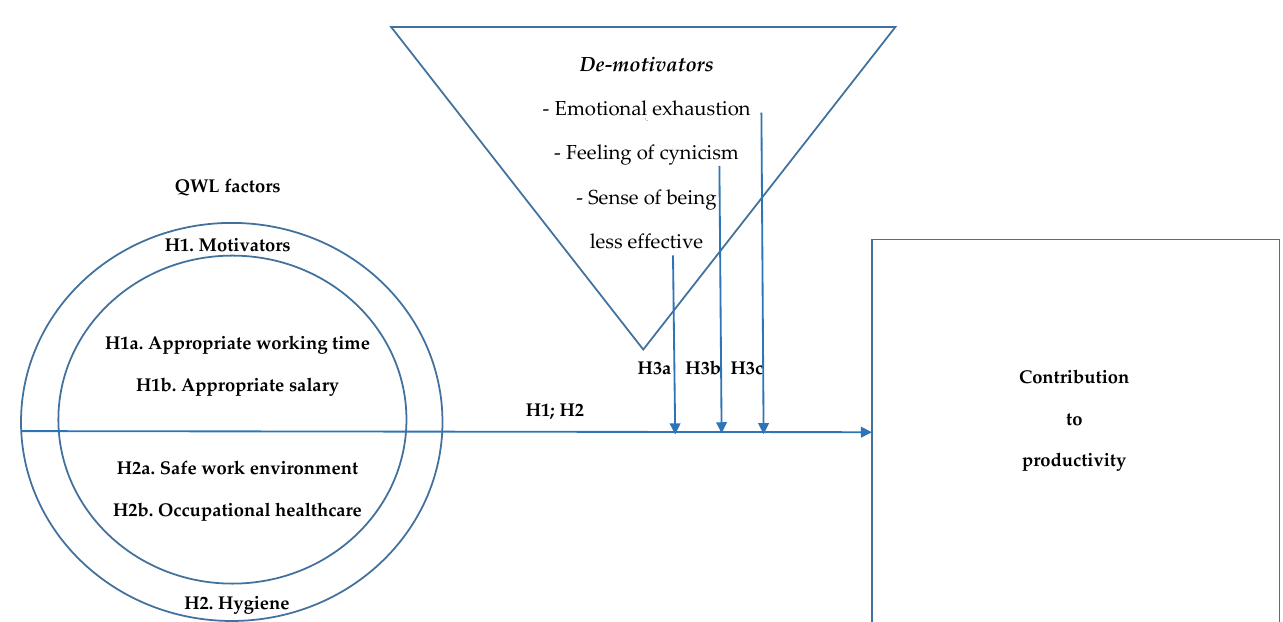
Figure 1. Integrating quality of work life (QWL) factors into the trichotomy of (de)motivators of productivity in the workplace: an operational model of analysis.